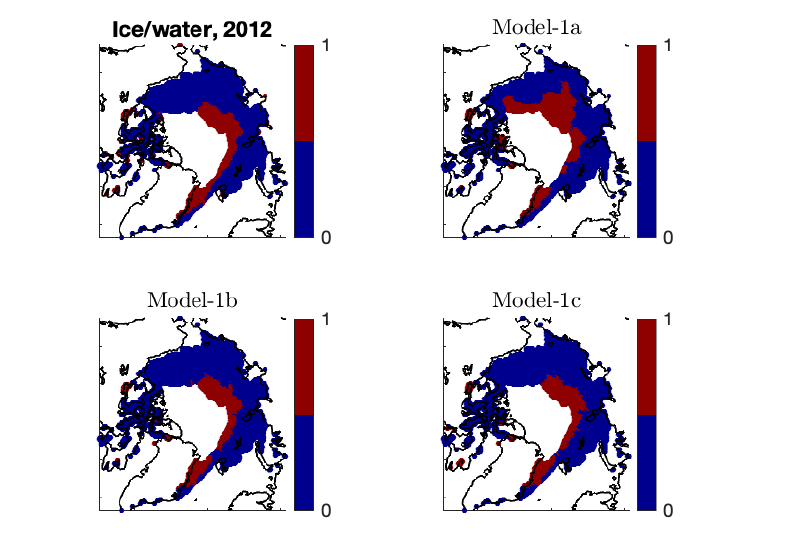
Figure A3. The observed ice/water status and the estimated ice/water status (by Model-1a, Model-1b, and Model-1c) at t =